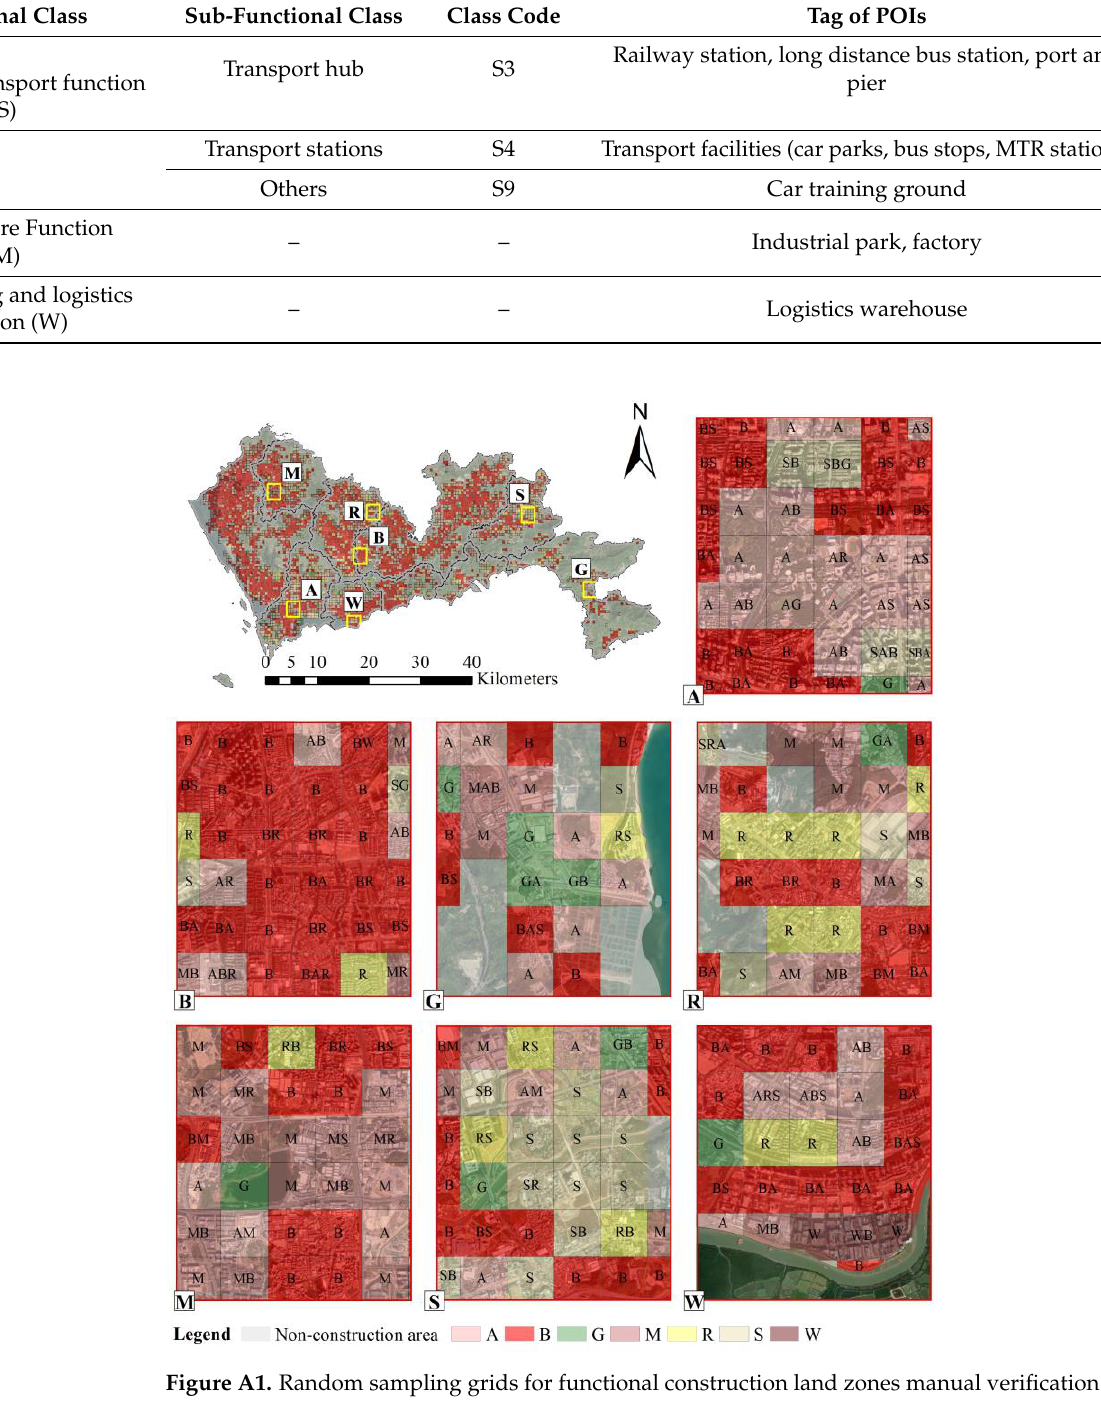
Figure A1. Random sampling grids for functional construction land zones manual verification.